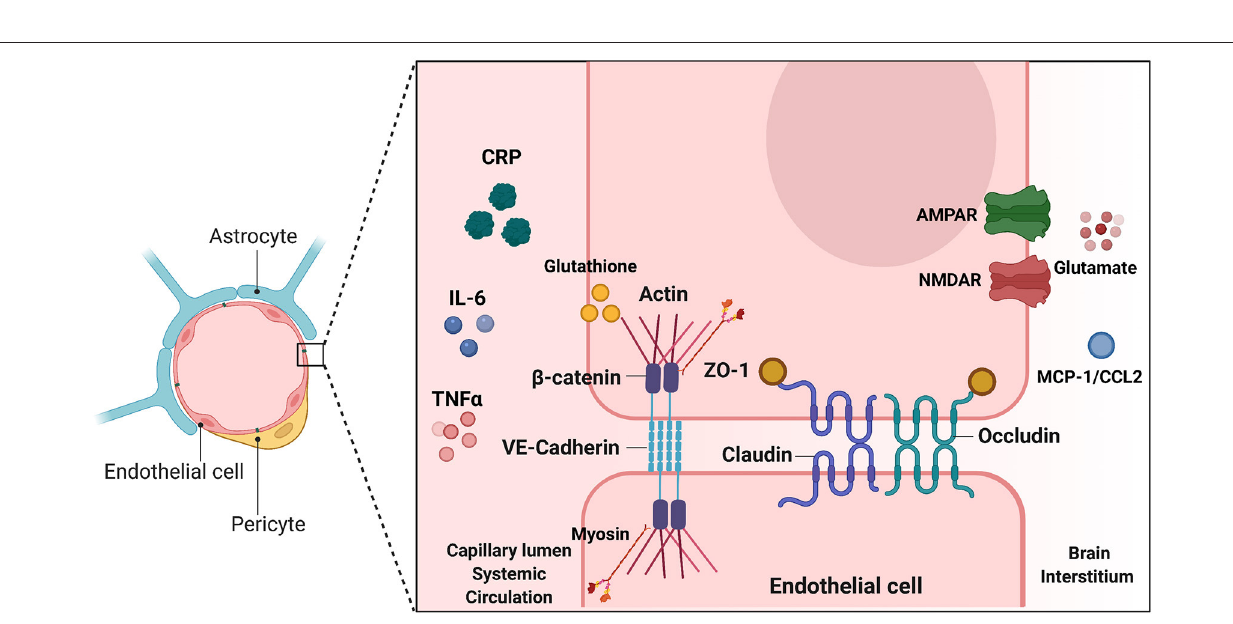
Frontiers in Neurology |